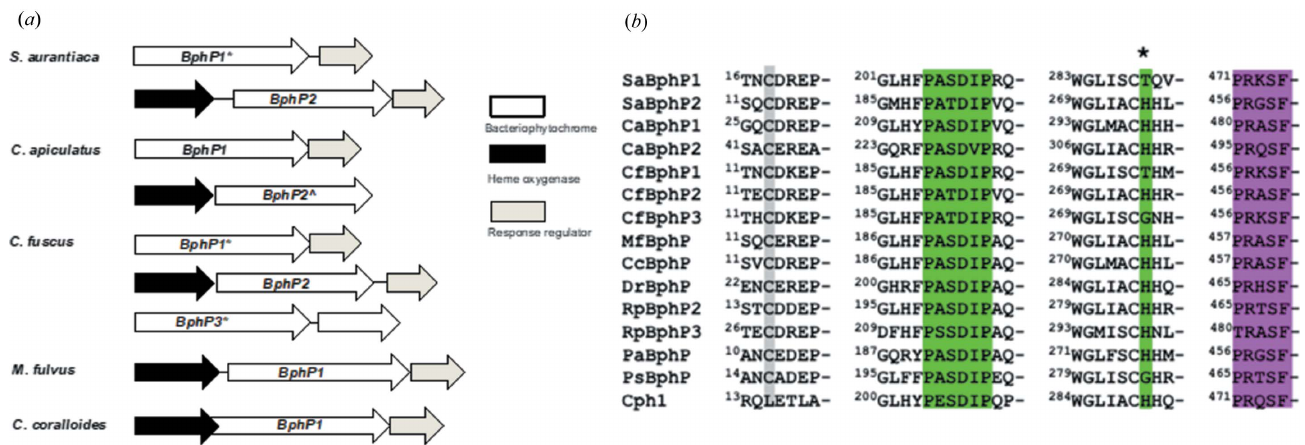
Figure 10 Gene organizations, sequence alignments, consensus sequences, and amino acids relevant for Pr to Pfr transitions. ( a ) Gene organization related to BphPs from S. aurantiaca DW4/3–1, Chondromyces apiculatus , Cystobacter fuscus , Myxococcus fulvus HW-1 and Corallococcus coralloides DSM 2259 (heme oxygenase opens the tetrapyrrole ring, the response regulator has histidine kinase activity). ( b ) Partial sequence alignment of BphPs. The PASDIP consensus sequence as well as position 289 of the Thr to His mutation in SaBphP1 are marked in green, the PRXSF consensus sequence is marked in pink, the Cys to which the BV is bound is marked in gray. SaBphP1 and SaBphP2 ( S. aurantiaca DW4/3–1); CaBphP1 and CaBphP2 ( C. apiculatus DSM 436); CfBphP1, CfBphP2 and CfBphP3 ( C. fuscus ); MfBphP ( M. fulvus HW-1); CcBphP ( C. coralloides DSM 2259); DrBphP ( D. radiodurans) ; RpBphP2 and RpBphP3 ( R. palustris CGA009); PaBphP ( P. aeruginosa PA01); PsBphP ( Pseudomonas syringae pv. tomato T1); Cph1 ( Synechocystis